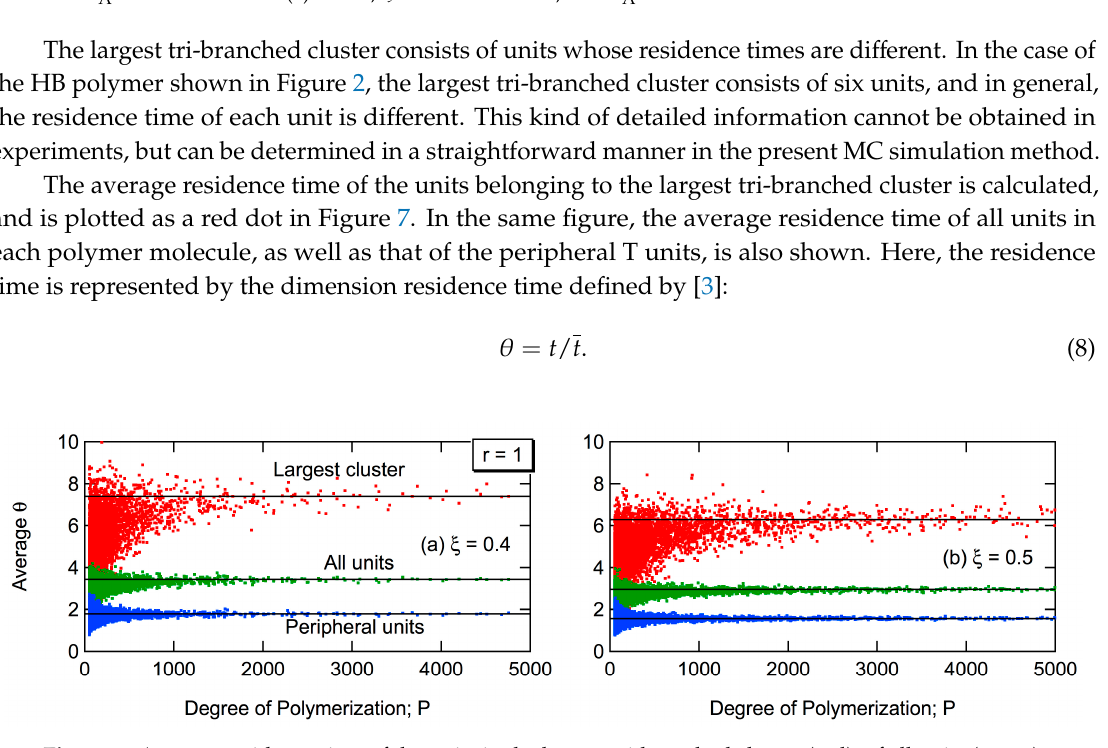
Figure 7. Average residence time of the units in the largest tri-branched cluster (red), of all units (green), and of the peripheral T units (blue) in each polymer molecule for the cases with r = 1. ( a ) ξ = 0.4, and ( b ) ξ = 0.5.